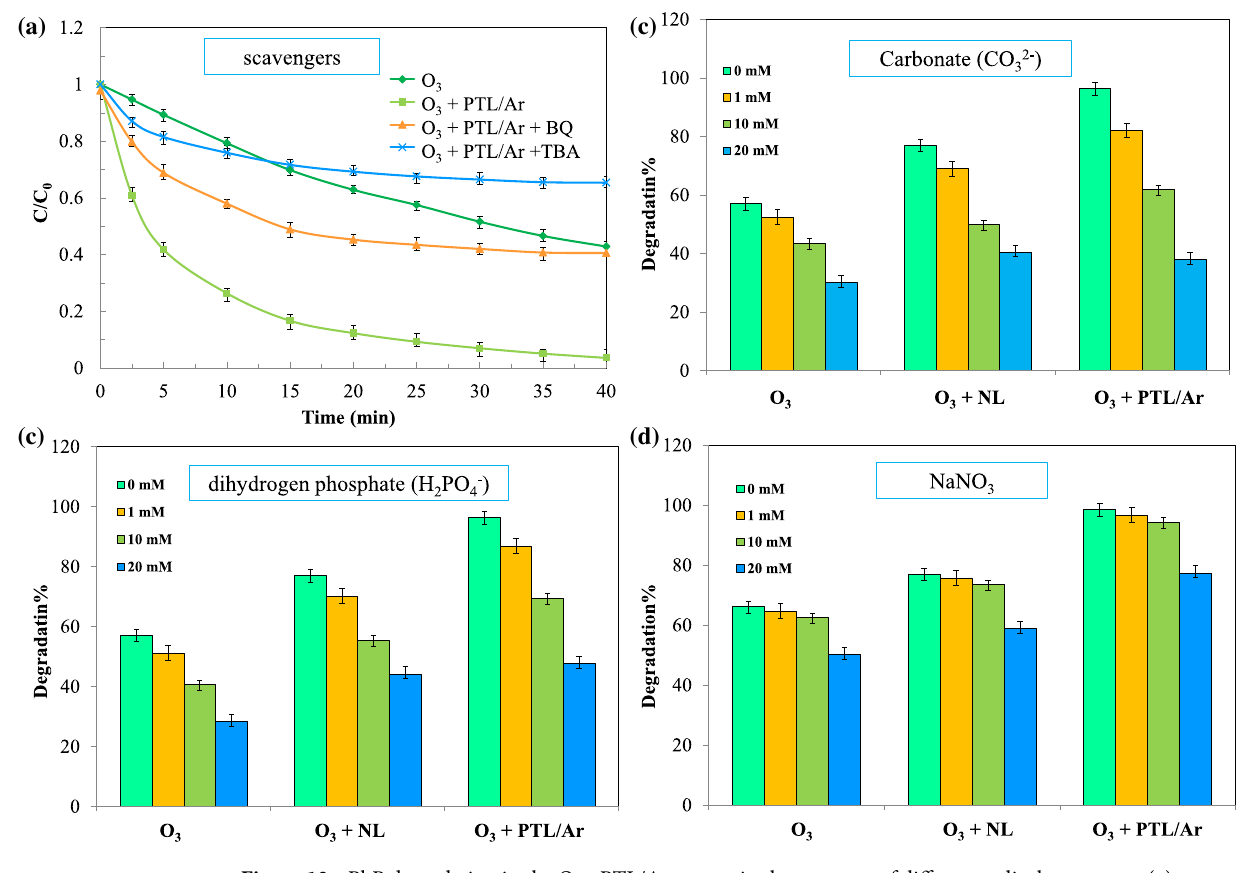
Figure 13. PhP degradation in the O 3 + PTL/Ar system in the presence of different radical scavengers ( a ) and CO 3 2− ( b ), H 2 PO ( c ) and NaNO 3 (d) ([PhP] 0 = 30 mg/L, [scavengers] 0 = 10 mM, [O 3 ] 0 = 11 mg/L, catalyst dosage = 0.75 g/L, pH 0 =